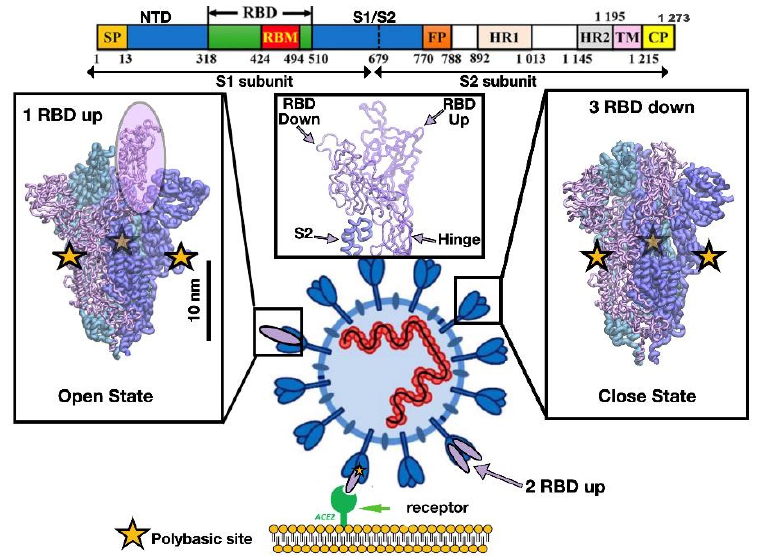
Figure 1. Representation of the different conformations of the receptor-binding domain (RBD) in the Acute Respiratory Syndrome—novel Coronavirus 2 (SARS-CoV-2) spike protein. Cell recognition is initiated by the RBD transition from down to up conformation that involves the RBD detachment from S2 mediated by the hinge region as depicted in the middle panel. Then, as a result of the high affinity between the RBD in the up conformation and the angiotensin-converting enzyme 2 (ACE2) receptor, binding takes place. The sequence of one chain of the spike protein is shown on top as well as the residue numbers for several protein domains. The bar shows the typical length scale for the whole system. The fusion of the viral and cell membrane takes place by surface proteases that cleave each chain at the polybasic sites (yellow stars) located at the interface of S1/S2 subunits.